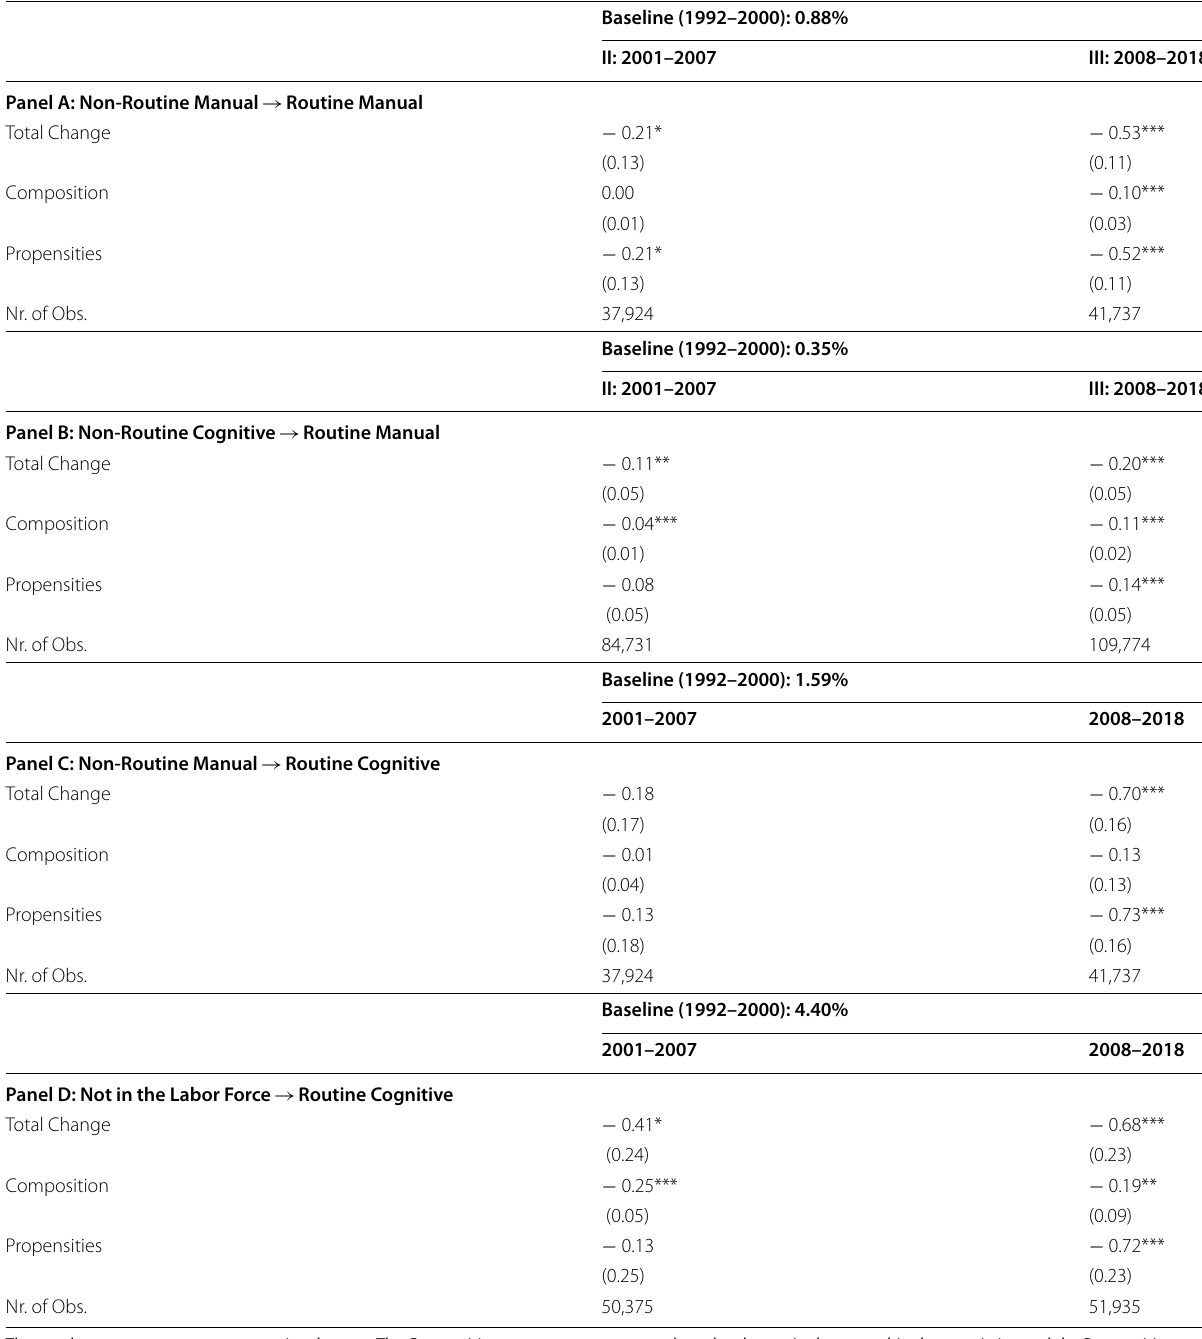
Table 4 Oaxaca Decompositions of Inflow Rates into Routine